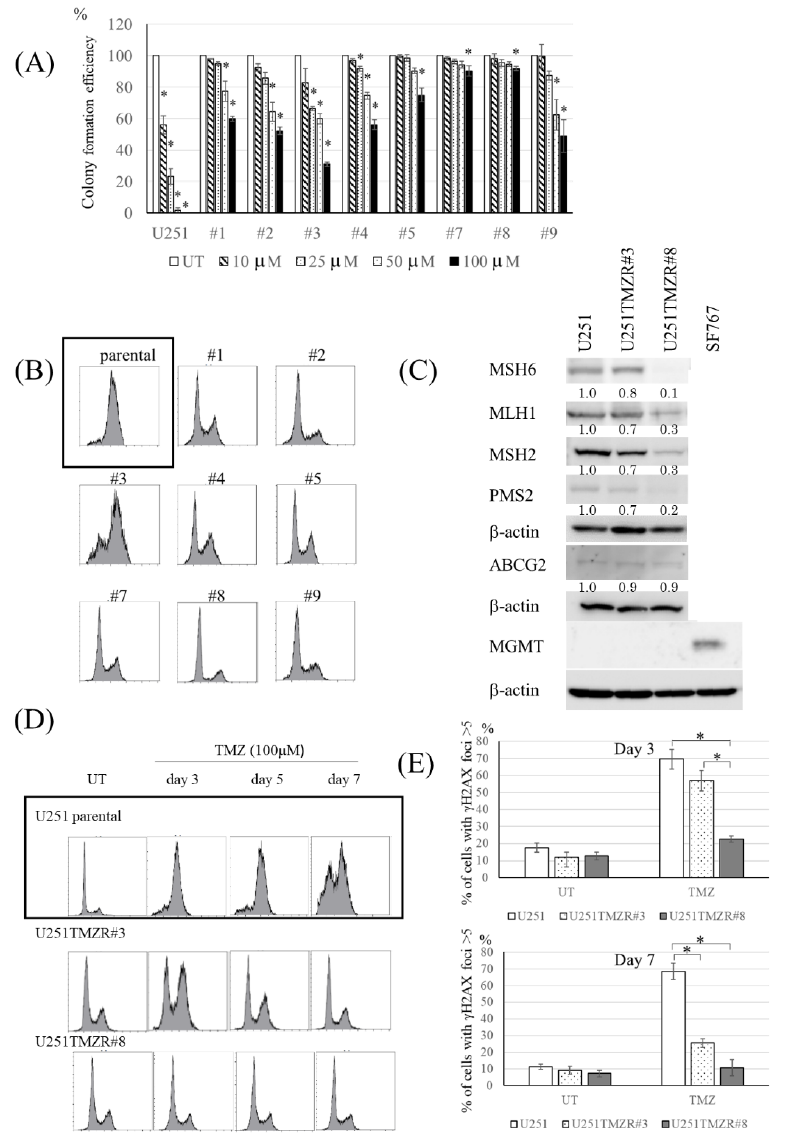
Figure 1. TMZ-resistant U251 clones had different characters. ( A ) Colony formation efficiency of U251 and U251-derived TMZ-resistant clones following TMZ exposure (0–100 µ M, 3 h). ( B ) Fluorescence-activated cell sorting (FACS) analysis of cell cycle distribution in U251 (parental) and U251-derived TMZ-resistant clones 3 days after TMZ (100 µ M, 3 h) exposure. Each clone showed different patterns of cell cycle phase distributions. ( C ) Western blot analysis of MMR- related proteins (MLH1, MS2H, MSH6, and PMS2), ABCG2, MGMT, and β -actin levels in U251 parental, U251TMZR#3, and U251TMZR#8 cells. SF767 cells were used as positive control for MGMT expression. ( D ) FACS analysis of cell cycle distribution in U251 (parental), U251TMZR#3, and U251TMZR#8 cells 3–7 days after TMZ (100 µ M, 3 h) exposure. TMZ-induced G2/M arrest rmained at least by day 7 in U251 (parental) cells. TMZ-induced G2/M arrest recovered sooner in U251TMZR#3, whereas TMZ did not induce G2/M arrest in U251TMZR#8. ( E ) Quantitative data from immunofluorescence analysis of γ -H2AX foci in U251, U251TMZR#3, and U251TMZR#8 cells 3 and 7 days after TMZ exposure (100 µ M, 3 h)., * p <